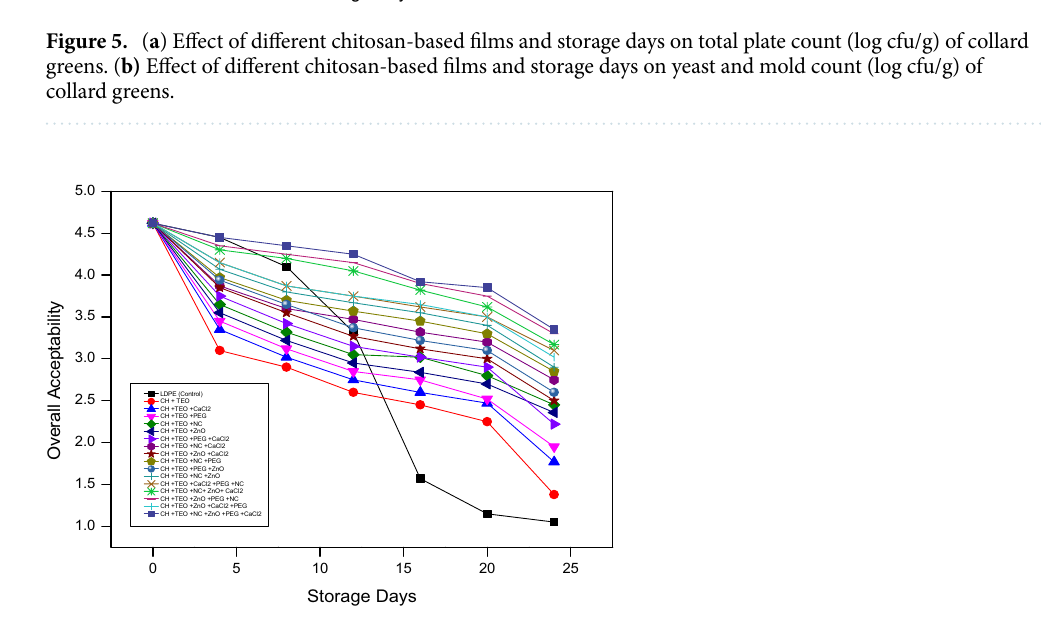
Figure 6. Effect of different chitosan-based films and storage days on overall acceptability of collard